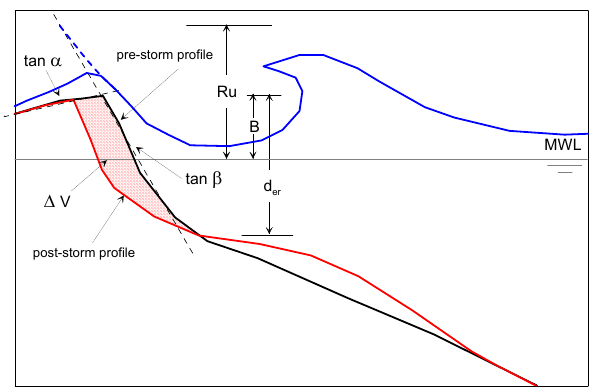
Fig. 5. Storm-induced beach hazards